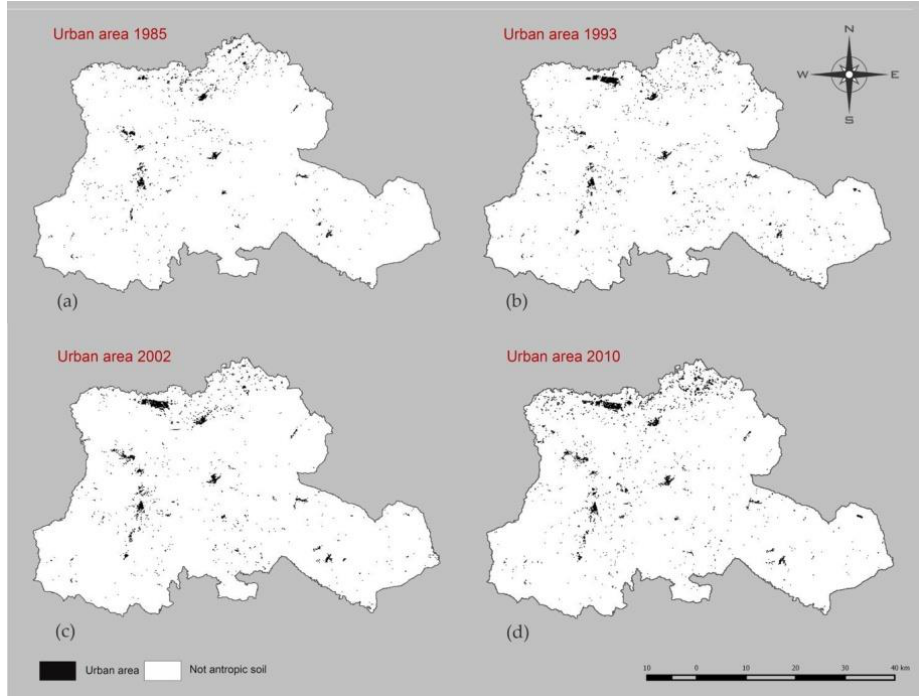
ISPRS Int. J. Geo-Inf. 2016 , 5 , 109